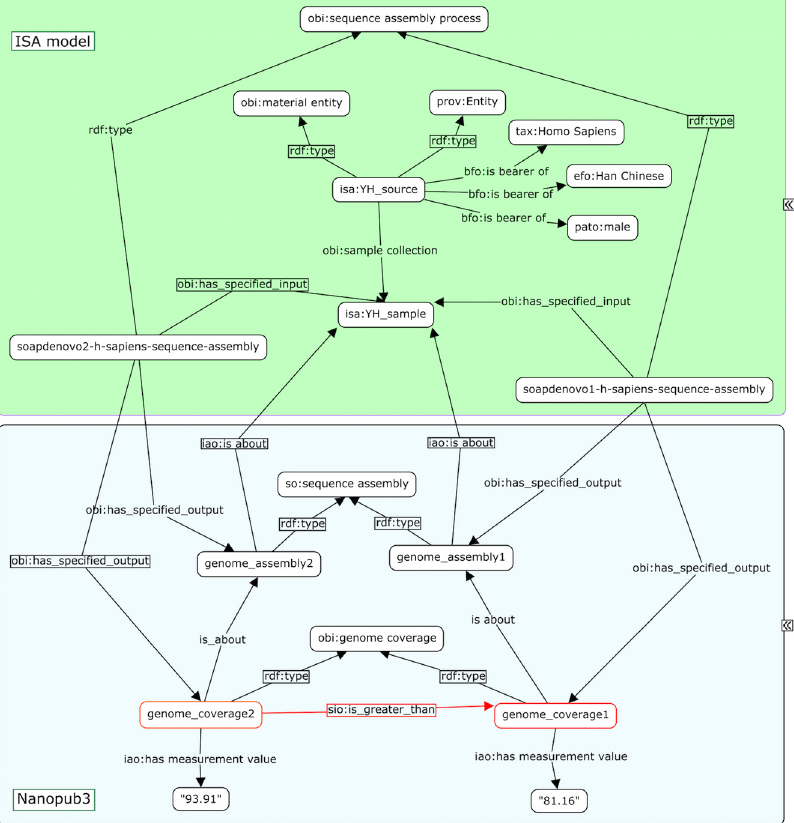
Fig 3. A detailed view showing how linked data representation of an ISA experiment (upper pane, in green background), with one of the finding expressed as Nanopublication statements, (lower pane), where a red outline indicates the key